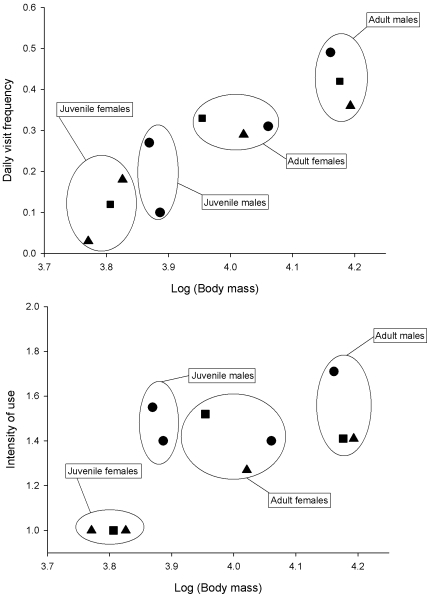
Relationship between indices of supplementary food use and body mass of lynx sharing three breeding territories.Upper panel: daily visit frequency; lower panel: intensity of use. Territory 1: circles; territory 2: triangles; territory 3: squares.